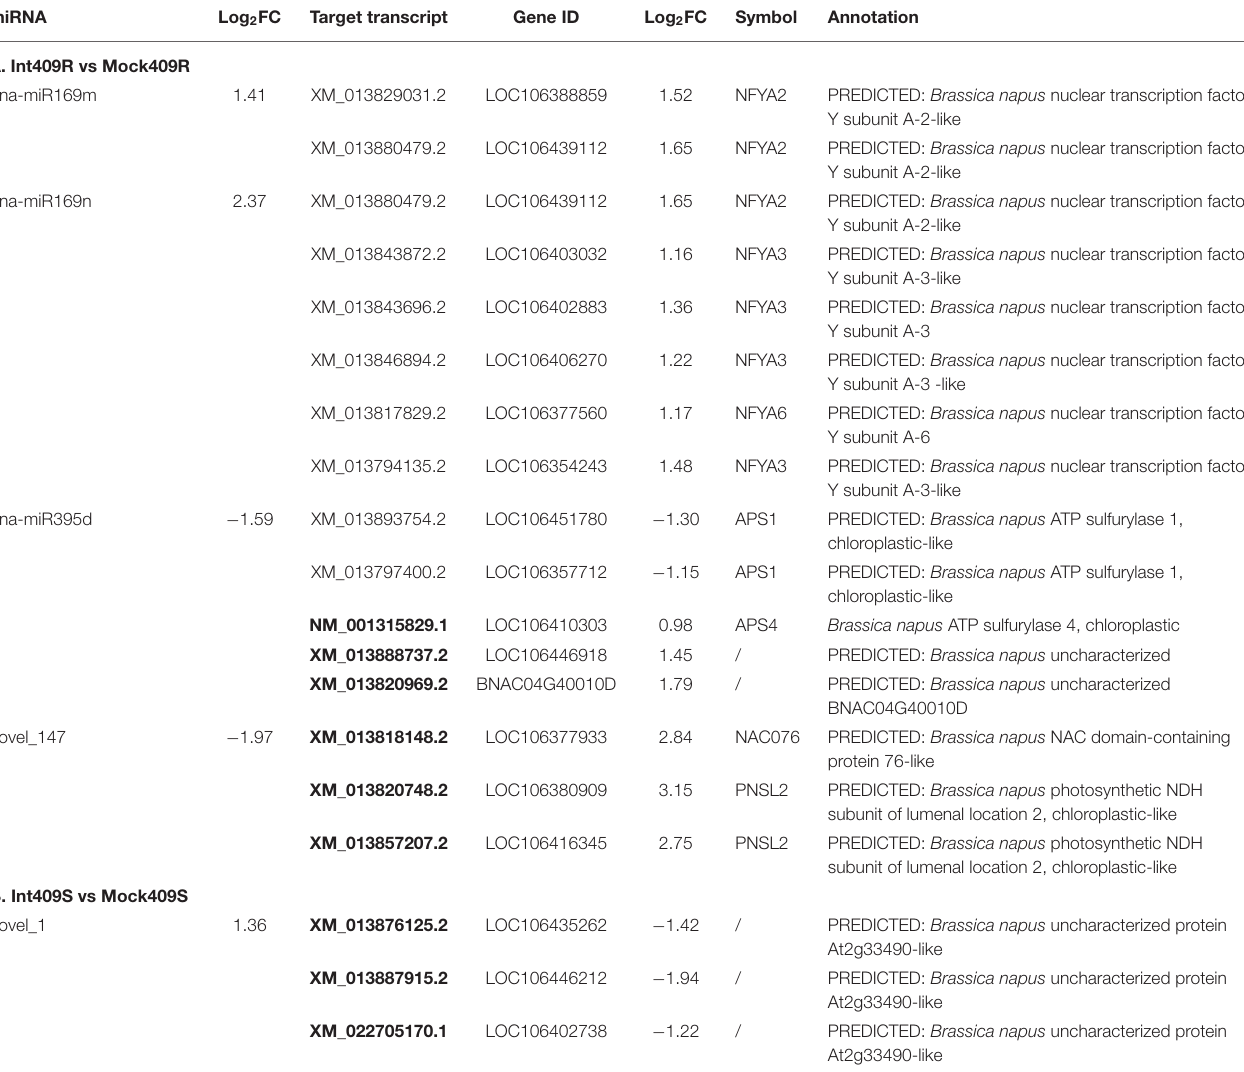
TABLE 6 | Differentially expressed miRNA-target pairs in response to P. brassicae ( p < 0.05, |log 2 FC| > 1).